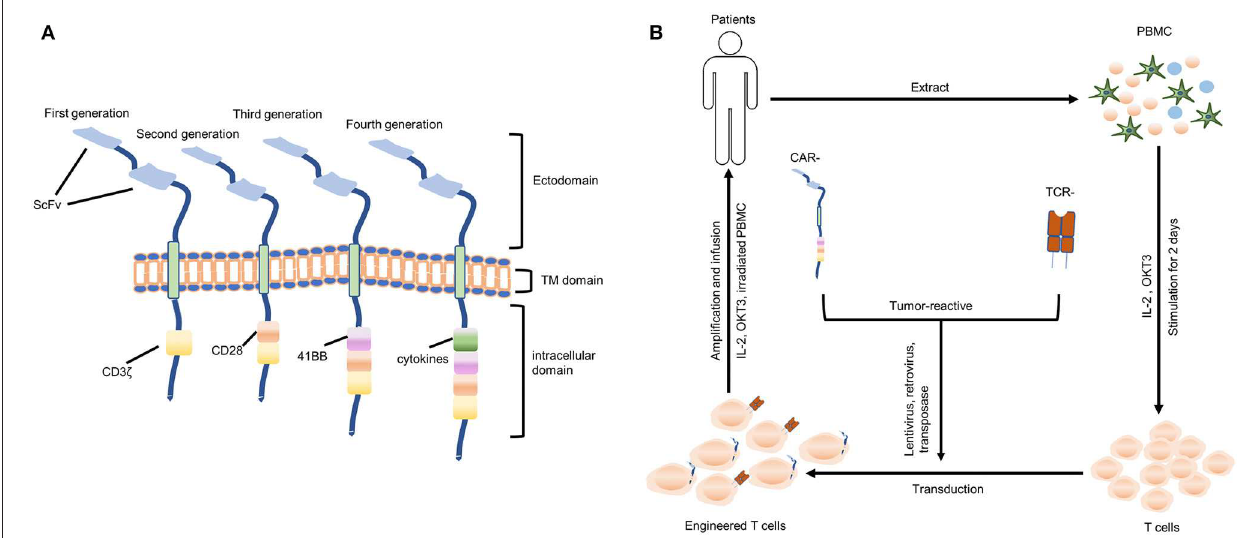
FIGURE 2 | Genetically engineered T cells (CAR- and TCR-) transfer. (A) Structures of four generations of CAR-T cells. ScFv, single-chain variable fragment; TM, transmembrane. (B) A “blueprint” for the therapy of patients using autologous genetically engineered T cells (CAR T-cells or TCR